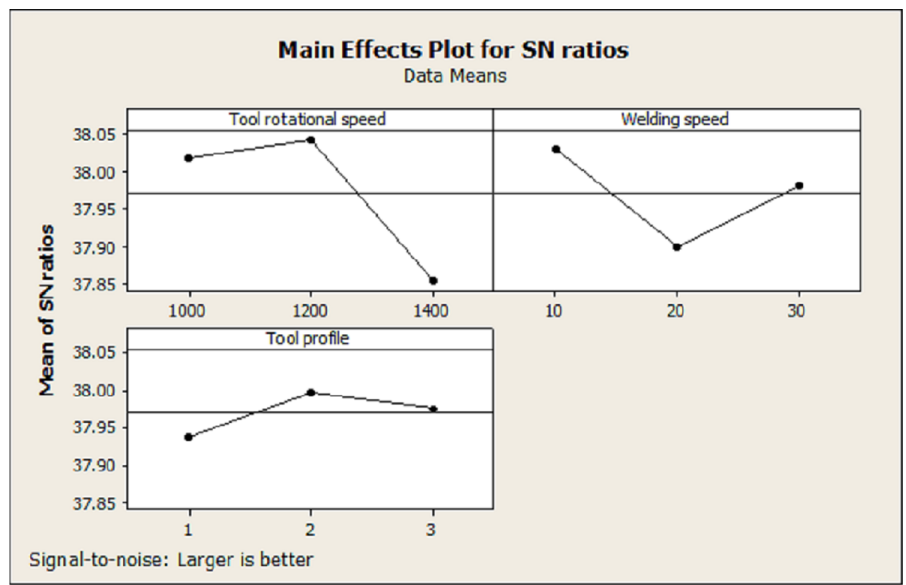
Figure 10. Main effects plot for the S/N ratio for hardness in the SZ.